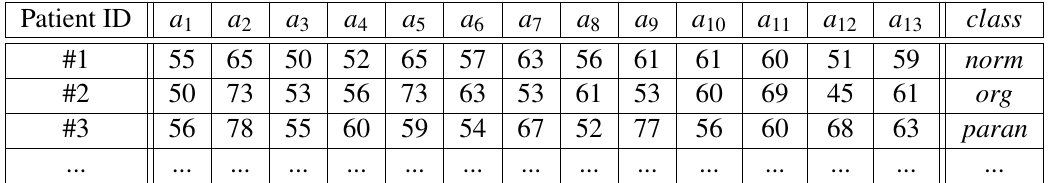
Table 1: An input data for Copernicus